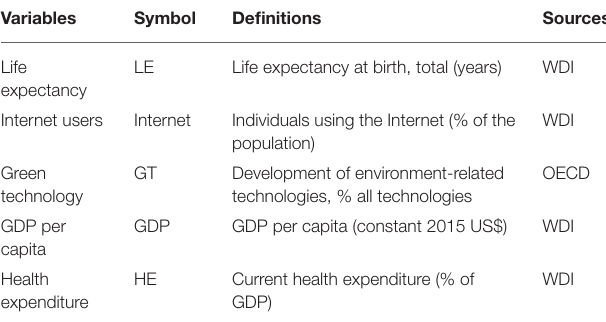
TABLE 1 | Data definitions and sources.